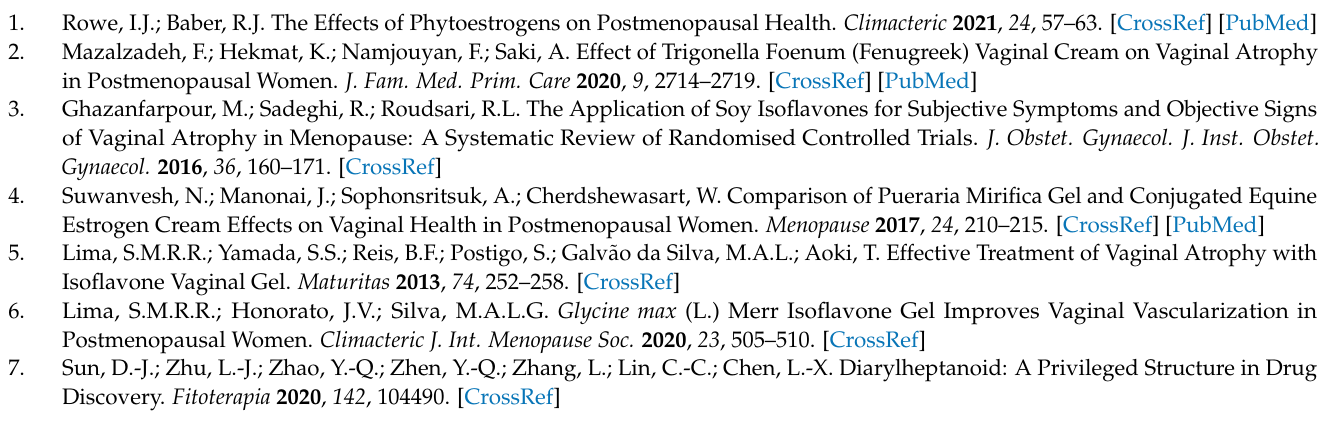
Figure S3: Macroscopic characteristics of placebo gels (gels without C. comosa extract) prepared from various mucoadhesive